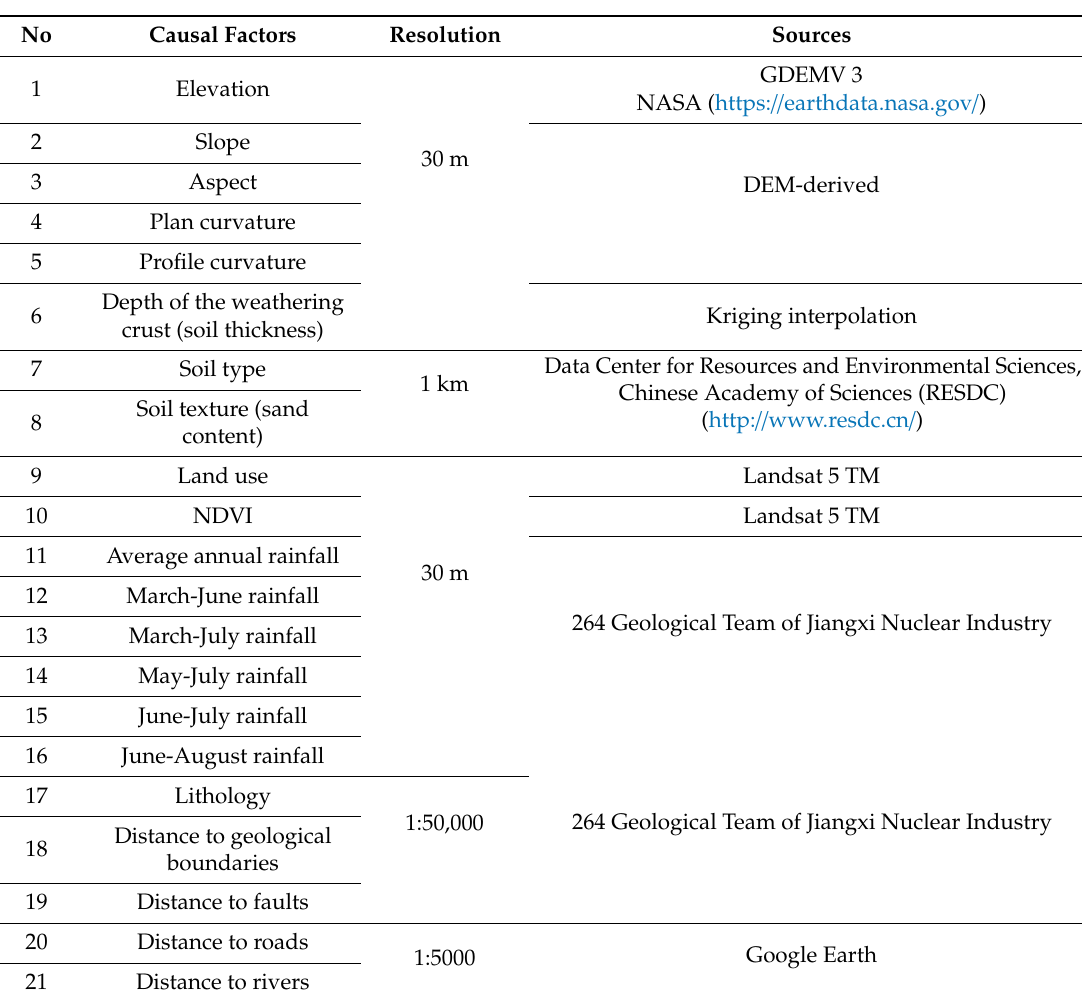
Table 1. Geo-information layers used as landslide causal